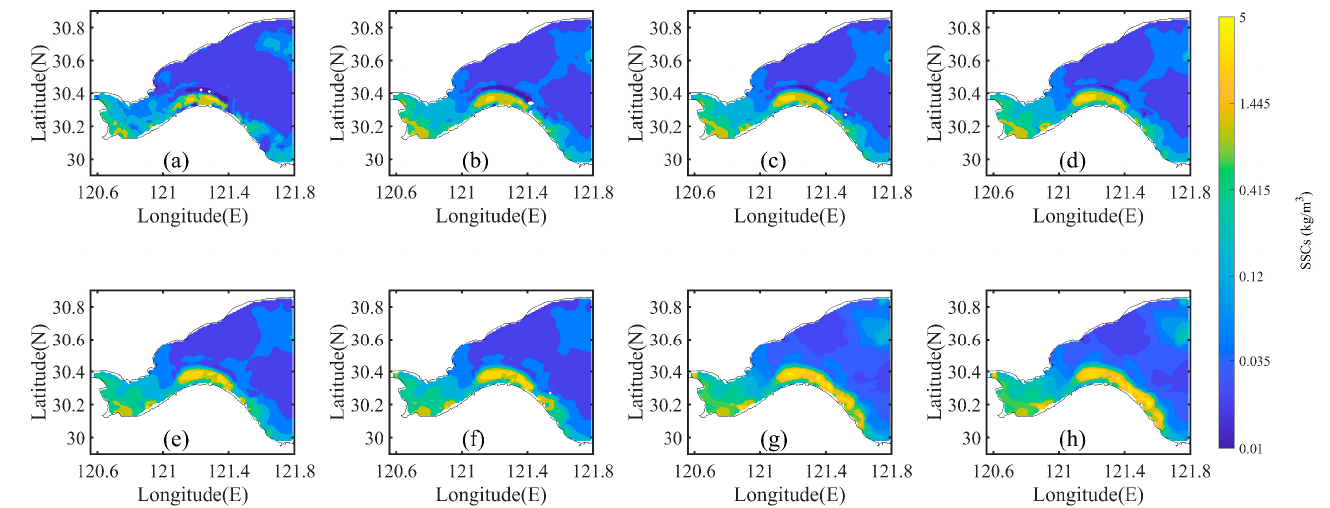
Figure 9. Spatial distribution of surface SSCs in PE22 during the simulation period: ( a ) Simulated result at the initial time, ( b – h ) Simulated results at each hour interval of the simulation period, re ‐ spectively.